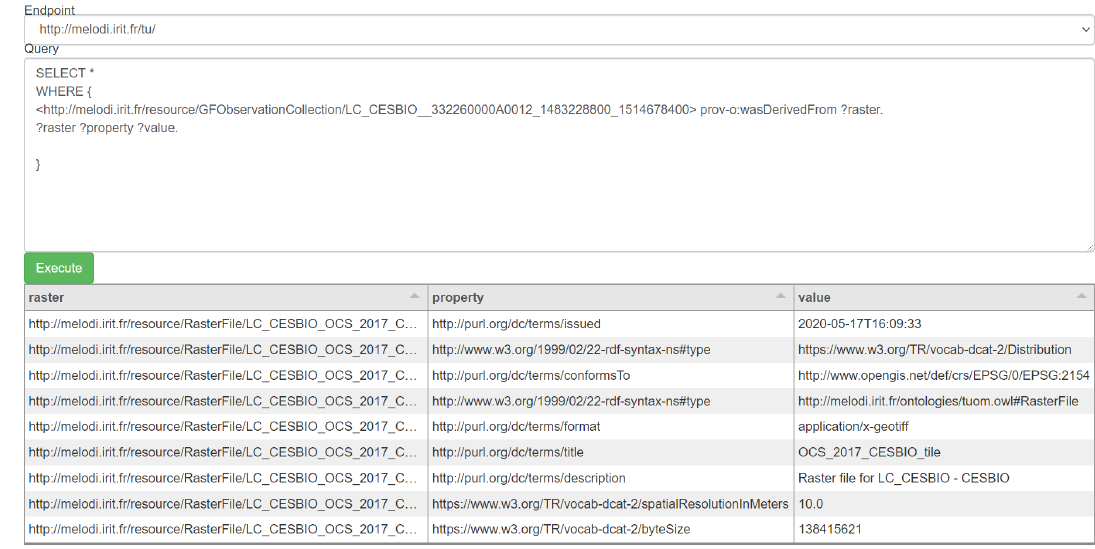
Figure 6. Data provenance and source